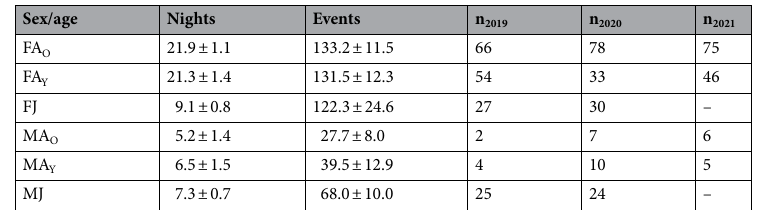
Table 2. Mean number of nights and events with standard error recorded per an individual and season (codes for sex and age categories: F = female, M = male, A = adult, O = old, Y = young, J = juvenile). Juveniles were not PIT-tagged in